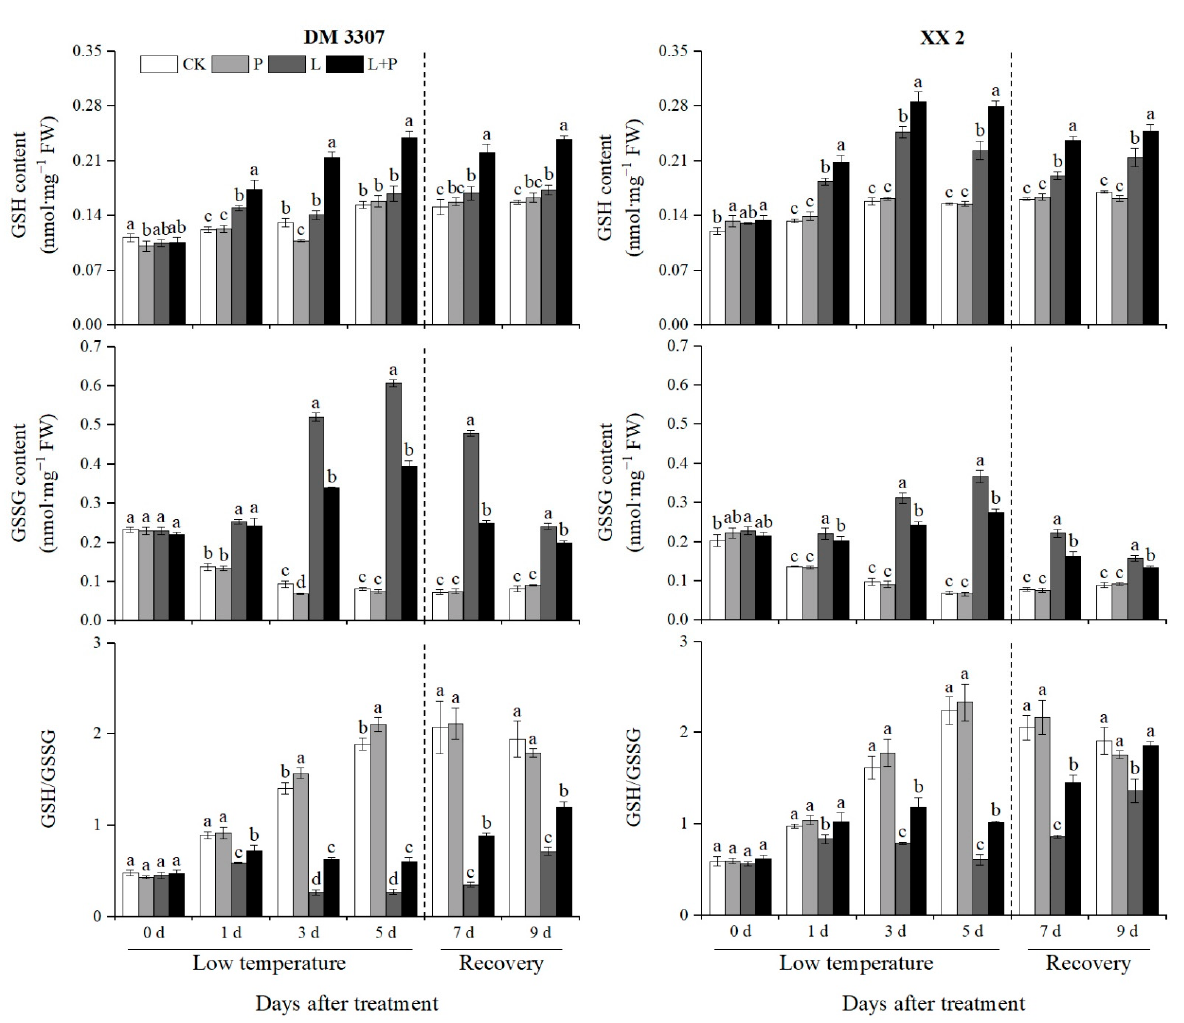
Figure 5. Effect of exogenous proline on the contents of GSH, GSSG and GSH/GSSG ratio in embryos of maize under the different treatment conditions. Notes: Data are expressed as mean ± standard deviation. Different letters within the same column indicate significant differences at the 5% level.